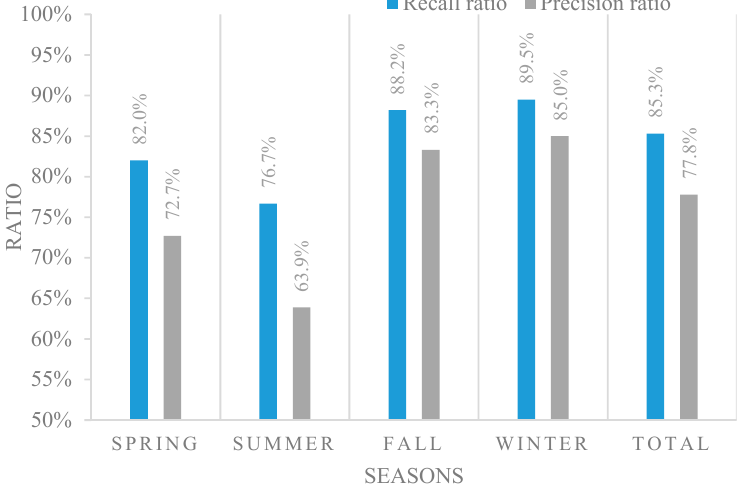
Figure 8. Recall ratio and precision ratio of automatically analyzed trough lines classified by seasons.